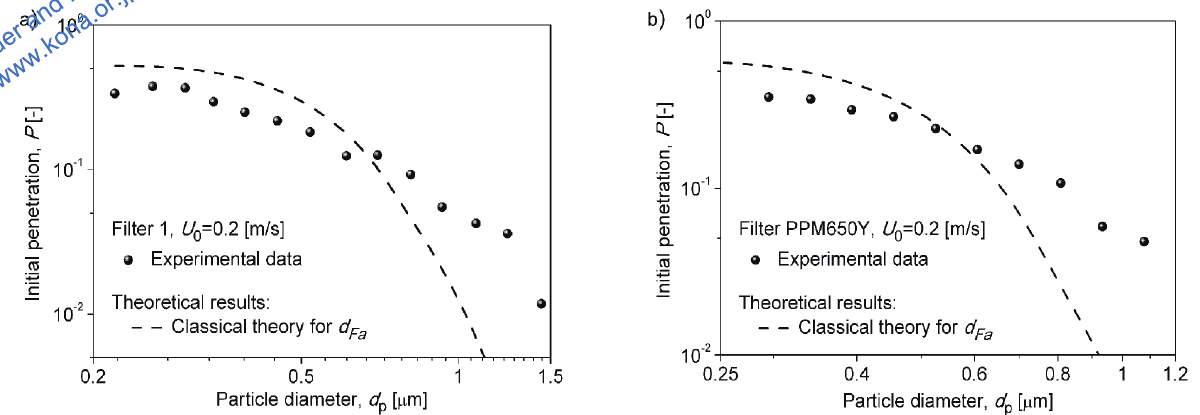
Fig. 7 Comparison of experimental values of the efficiency with results of calculations obtained using the classic theory for: Filter 1 (a) and Filter PPM650Y